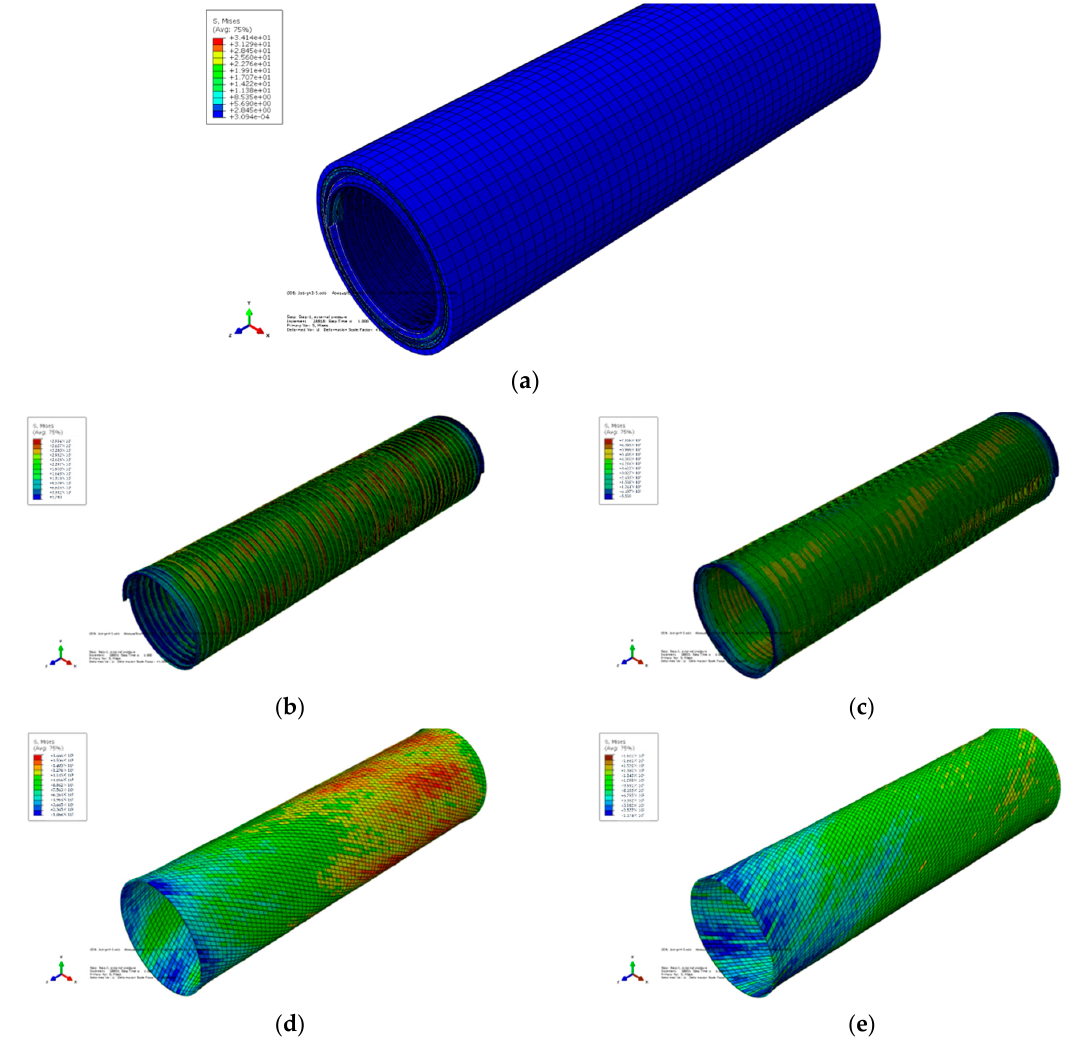
Figure 8. A stress nephogram under bending moment. ( a ) The riser; ( b ) Skeleton layer; ( c ) Com- pressive armor layer; ( d ) Internal tensile armor layer; ( e ) External tensile armor layer. The structural stress of each metal layer under torsion is as Figure 9 .